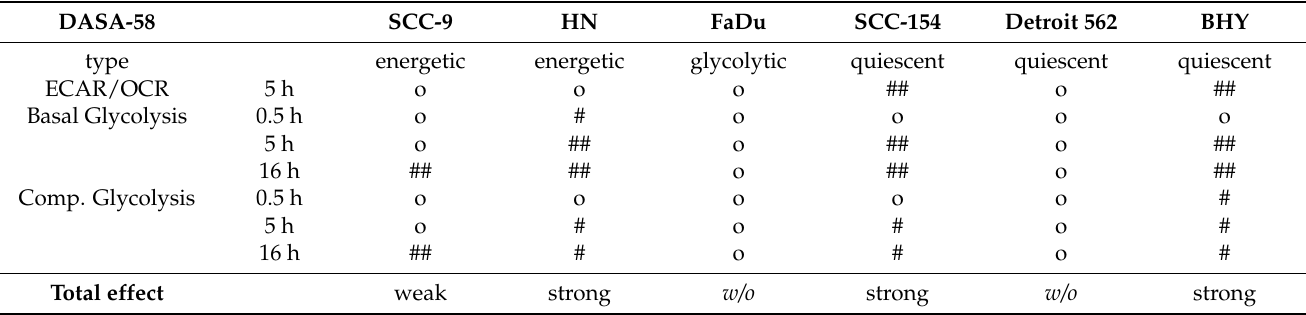
Table 1. Outcomes of DASA-58 treatment on HNSCC cell lines. o: no effect, #: small effect, ##: large effect. Five or more times small or large effect results in total effect “strong”, two to four times small or large effect results in total effect “weak”, zero to one time small or large effects results in total effect “ w/o ” (without effect). Comp.: Compensatory.